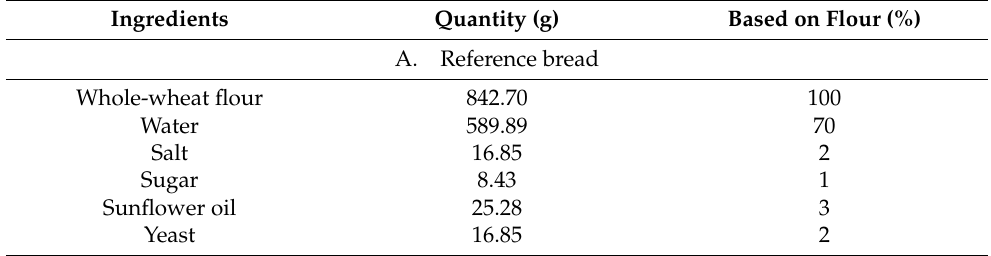
Table 1. (A) Reference and (B) sourdough bread recipes expressed as respective dosage (g) and based on flour (%)